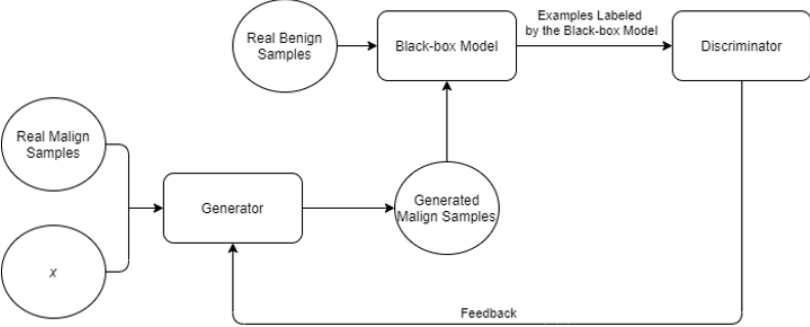
Figure 10. Overview of the enhanced GAN solution based on